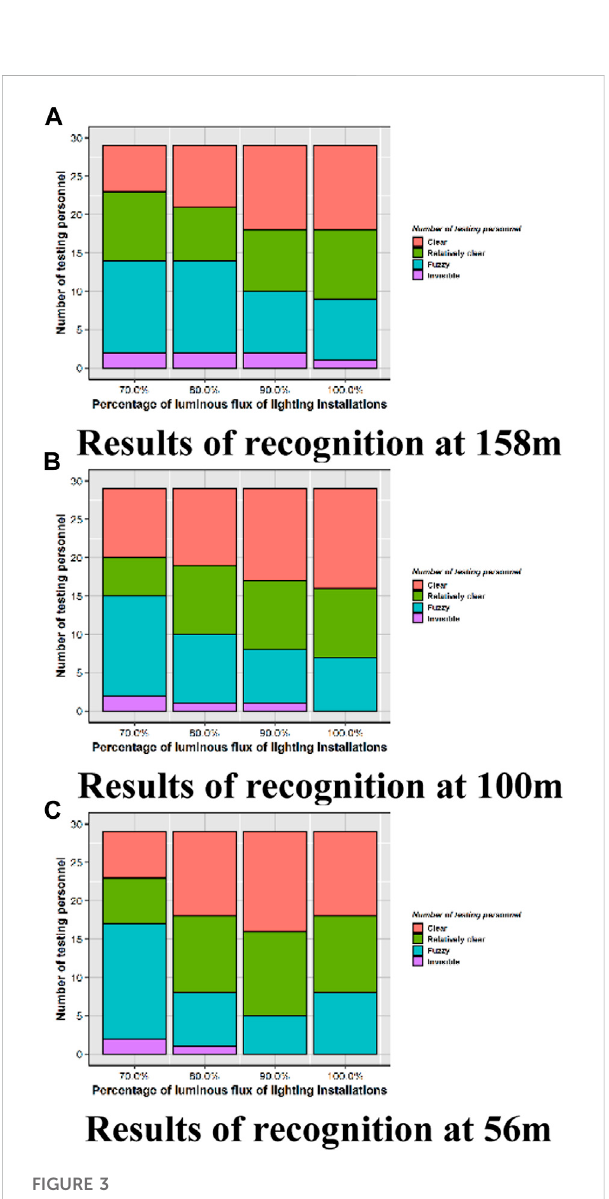
FIGURE 3 Results of small target